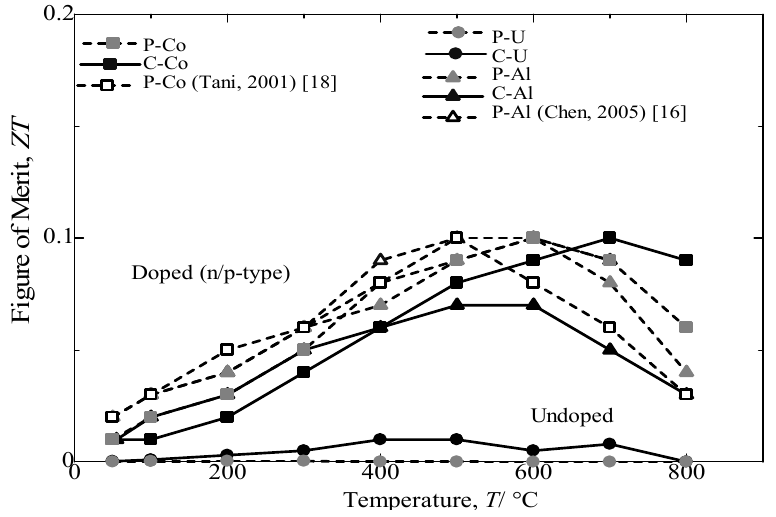
Figure 11. Variation in dimensional figure of merit, ZT , with the measuring temperature of samples at 900 °C for 5 the annealed β -FeSi 2